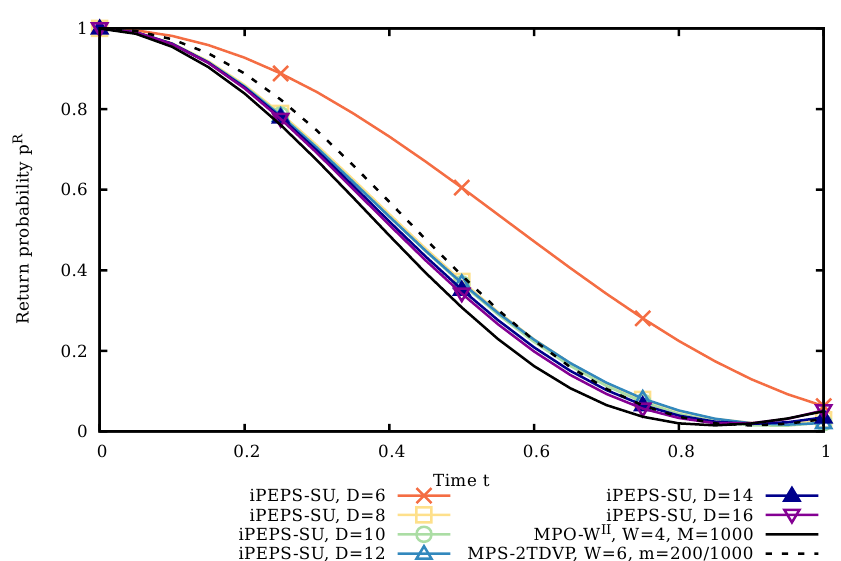
Figure 3: Return probability p R ( t ) calculated using iPEPS with the simple update and td-MPS on short times from an initial D (cid:48) = 4 state excited with a global hole density of 0.01 and J = 1 / 3 with various iPEPS bond dimensions D . We observe good convergence of the initial decay once D ≥ 8. Data is evaluated every δ t = 0.05, with symbols shown only for identification.